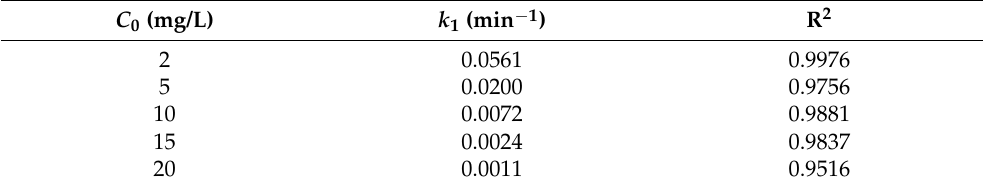
Figure 9. Linear correlation of 1/r 0 versus 1/C 0.